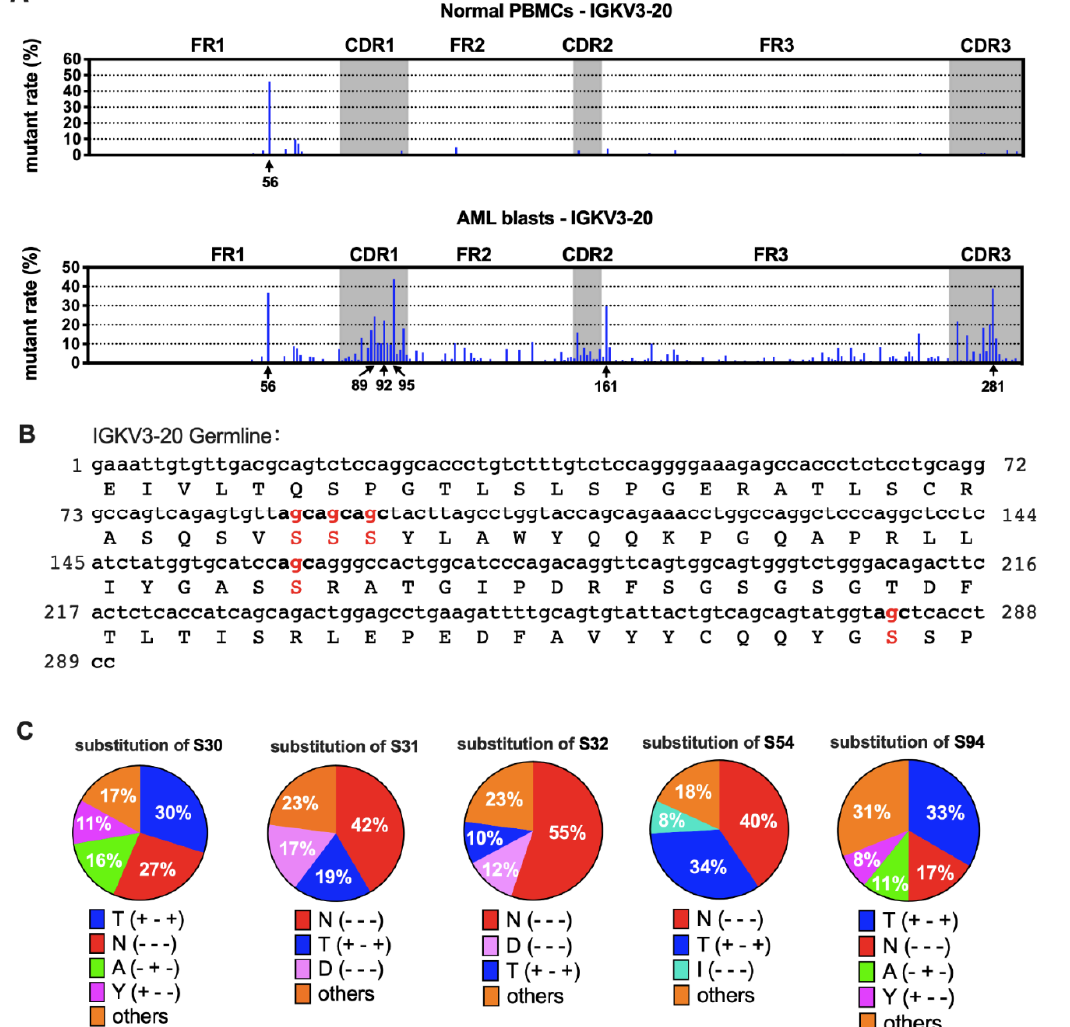
Figure 6. Mutation hotspots in IGKV3-20. ( A ) The mutation rates of V κ 3-20 nucleotides in normal PBMCs ( upper ) and AML blasts ( lower ). ( B ) Germline IGKV3-20 nucleotide and amino acid sequences. The frequently mutated nucleotides and amino acids are highlighted in red. ( C ) Substitu- tions of serine in the five mutation hotspots. The percentages shown are averages of AML blasts. The amino acid changes are indicated with “+” (same) or “-“ (different) in the parentheses in the following order: hydropathy, volume, and chemical characteristics [29]. For example, T (+ - +) indicates that the two amino acids, S and T, belong to the same hydropathy class and have the same chemical characteristics, but the volume is